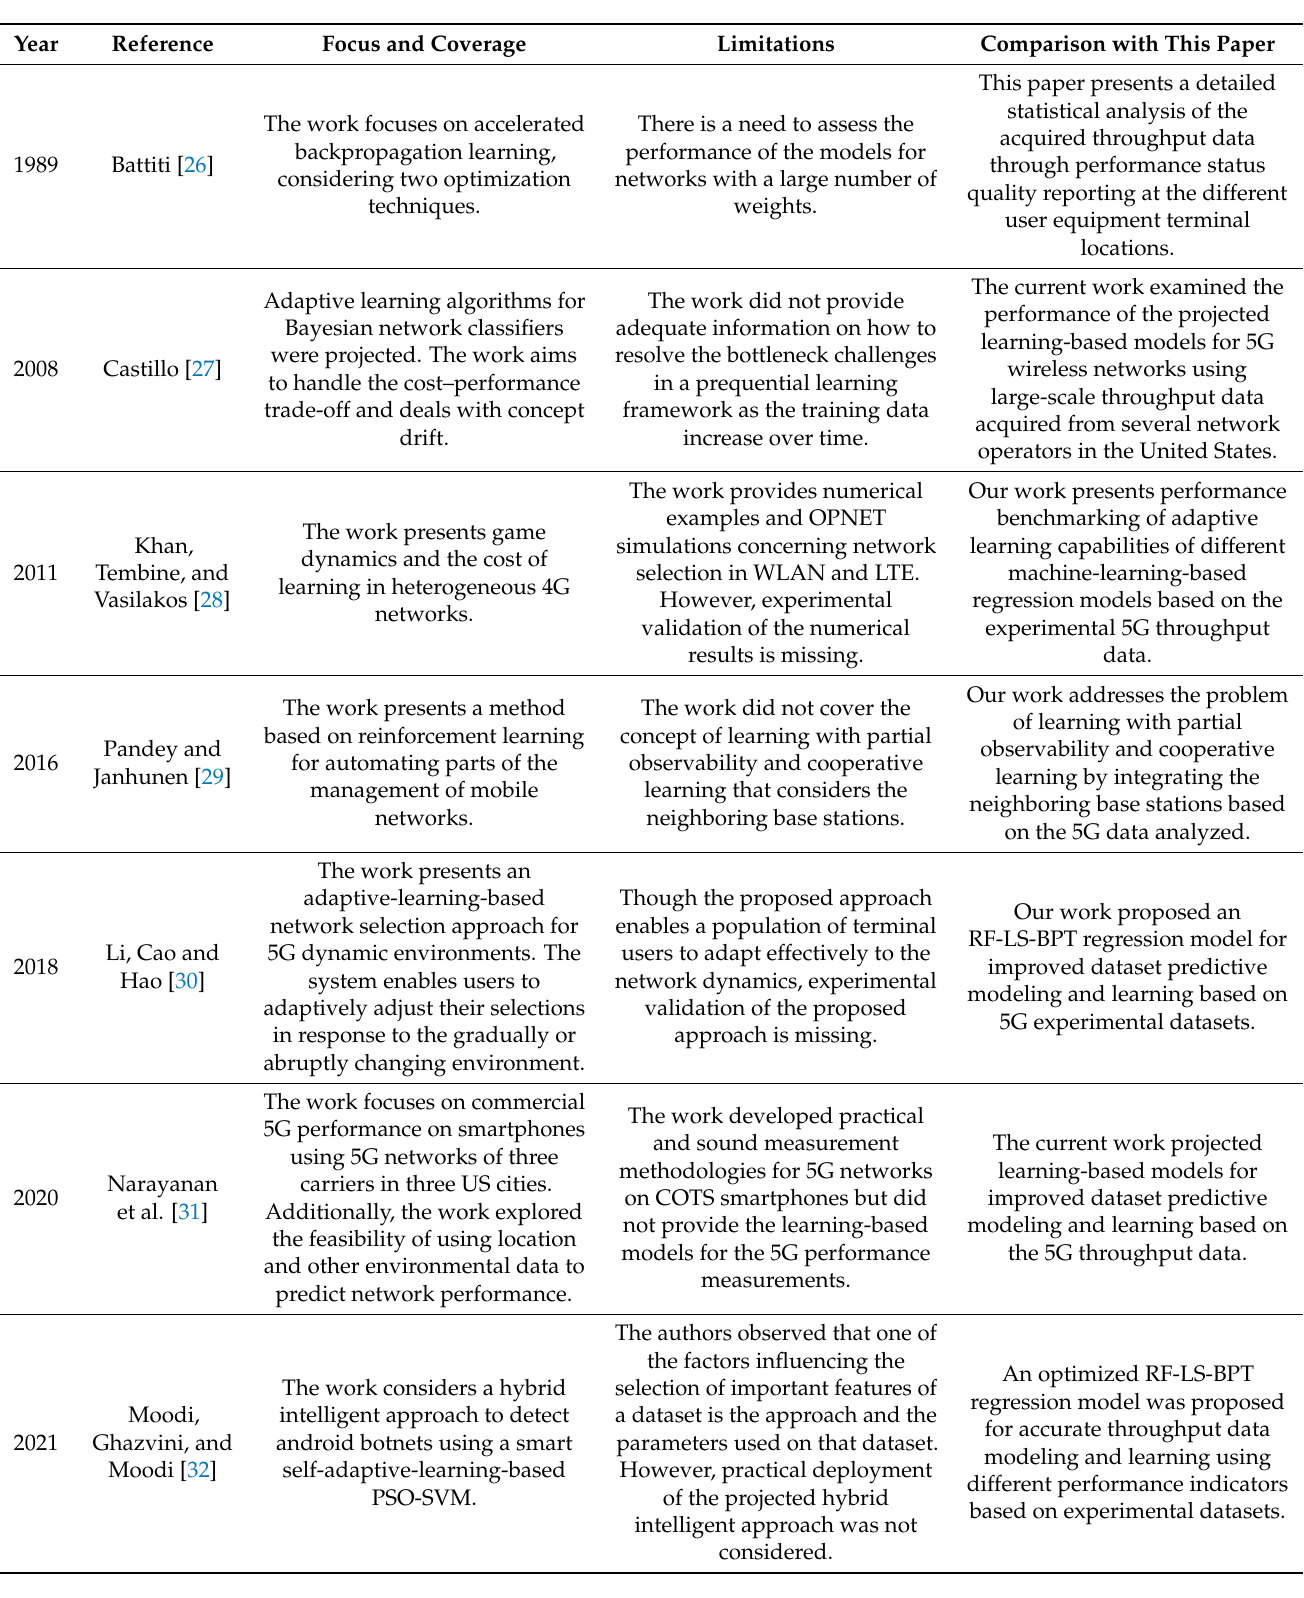
Table 1. Limitations of some related